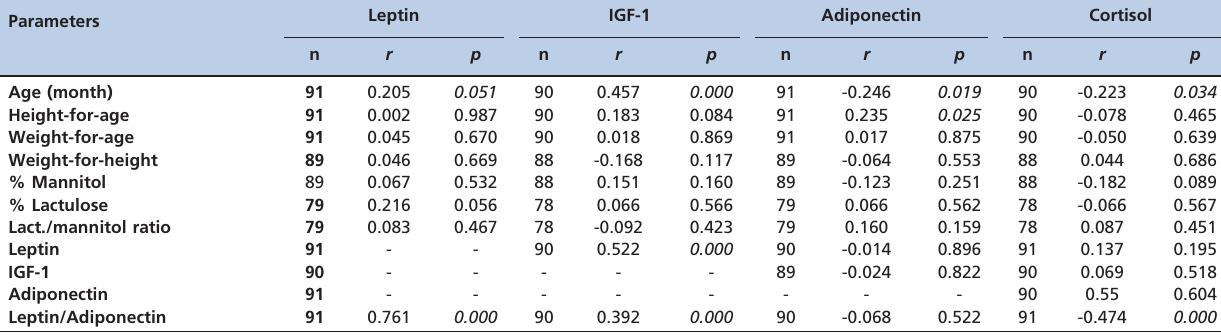
Table 2 - Spearman correlation coefficients for leptin, IGF-1, adiponectin, and cortisol plasma levels vs. age, anthropometric measures, and intestinal barrier function parameters in young children. Parameters